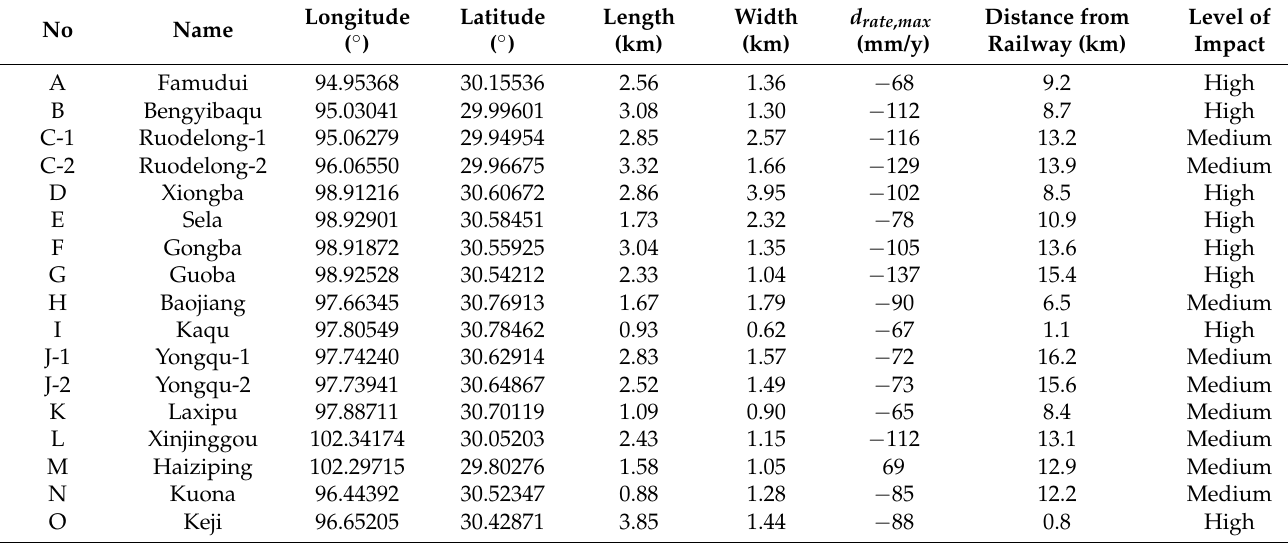
Table A1. Detailed information of 17 typical